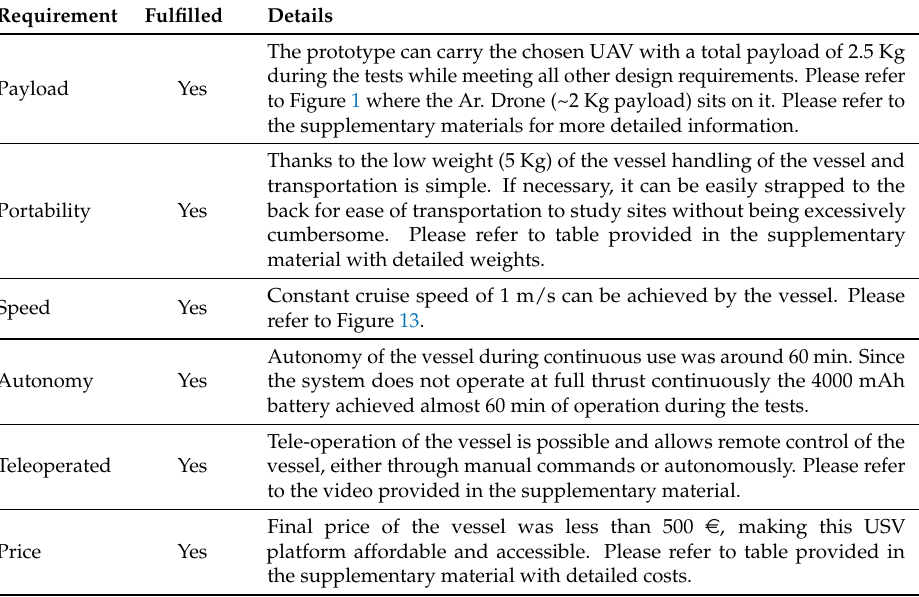
Table 3. System design requirements